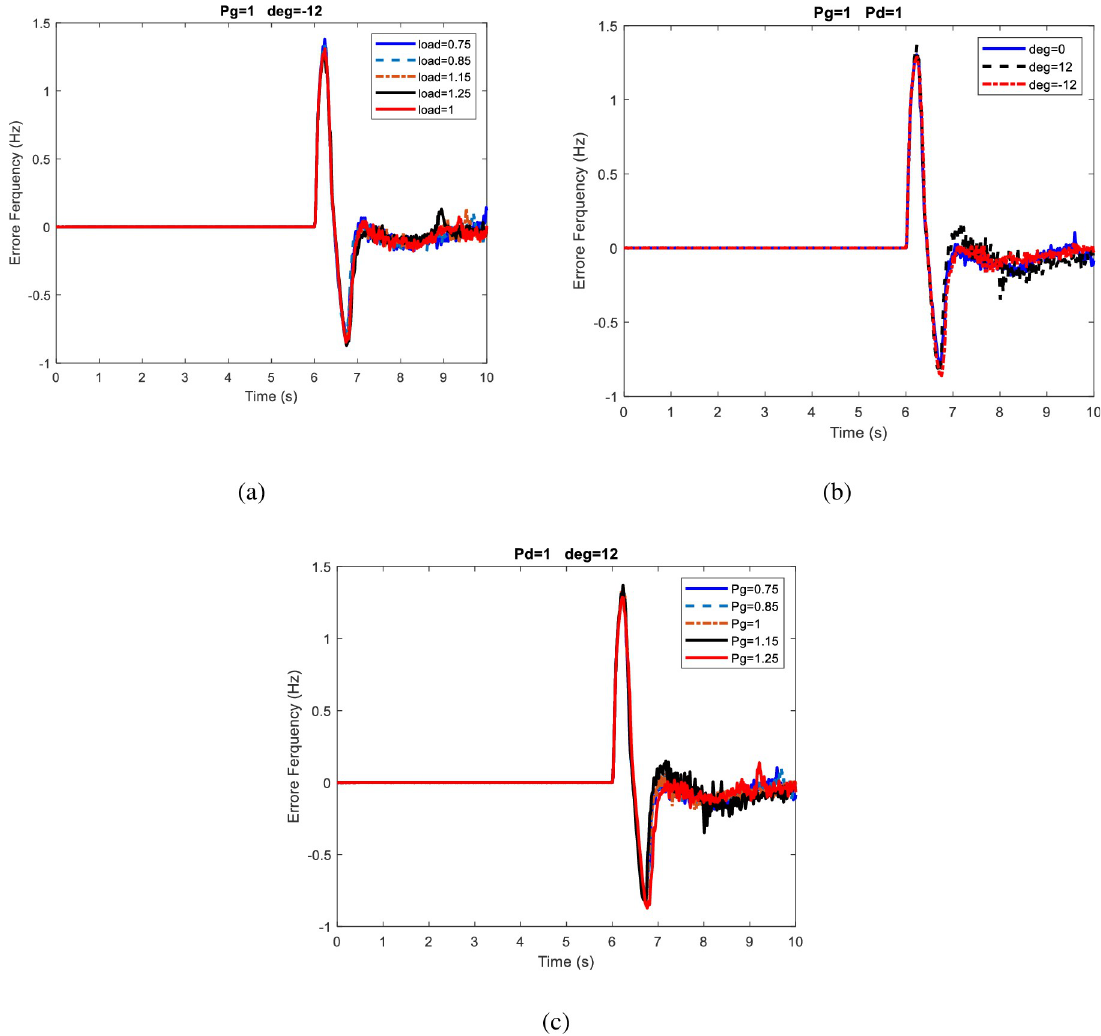
Fig 7. Comparison of frequency deviations in different modes for the second scenario. https://doi.org/10.1371/journal.pone.0257830.g007 Fig 9 compares several cases of frequency deviation in 10s for the fourth scenario. In this figure, frequency changes Due to load demand changes, Voltage angle, power generation changes are shown in Fig 9(A)–9(C) respectively. The effect of load demand changes (Fig 9 (A)), power generation changes (Fig 9(B)), and power exchange changes (Fig 9(A)) on fre- quency deviation has been greatly increased. It can even be seen that changes in power genera- tion and power exchange changes affect the maximum frequency deviation.